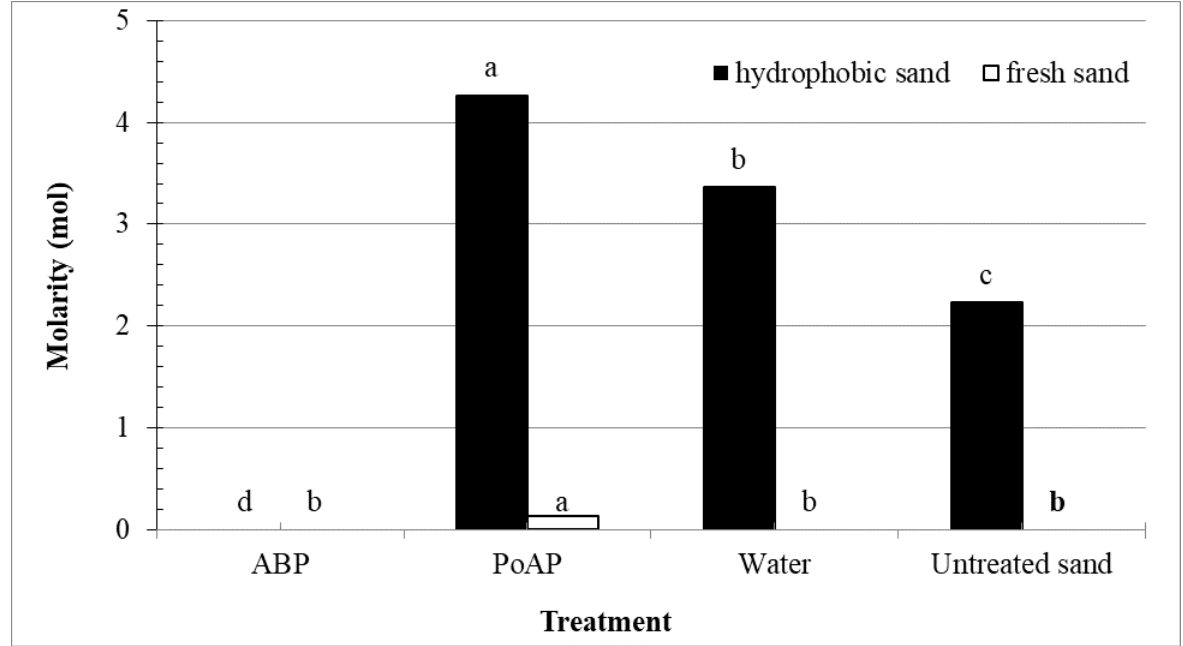
Figure 4. Hydrophobicity, determined by molarity of ethanol droplet (MED) test, of hydrophobic or fresh sand columns receiving three sequential treatment applications and following washes. Treatments included an alkyl block polymer (ABP), a polyoxyalkylene polymer (PoAP), and water, in addition to an untreated control (untreated sand). Bars labeled with the same letter for each sand were not significantly different based on Fisher’s Protected LSD at p < 0.05.